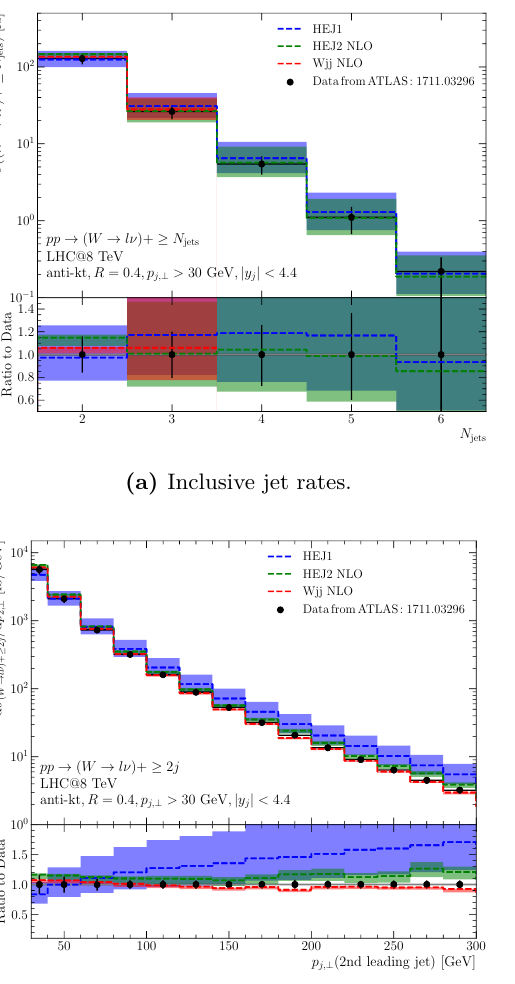
(c) Differential cross section for the transverse mo- mentum of the second leading jet. Figure 18. Predictions for pp → ( W → lν )+ ≥ 2 j for LHC@8TeV, compared to ATLAS data from [30]. The original HEJ1 predictions are shown in blue, the pure NLO predictions are shown in red and the new HEJ2 predictions incorporating the methods of sections 3 and 4 are shown in